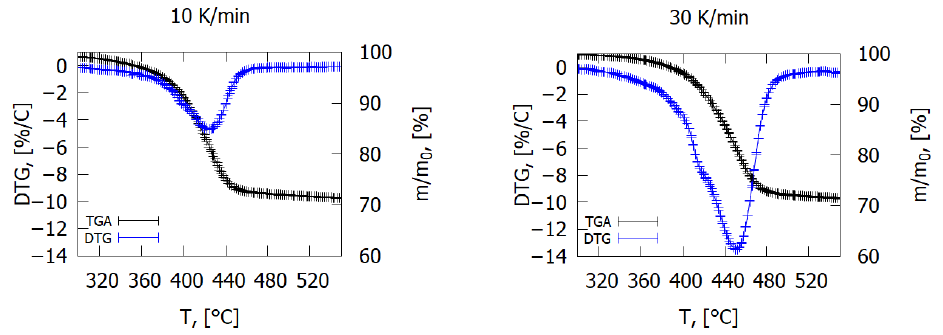
Figure 3. TGA data of GFRER (with curing agent #9) in inert medium.